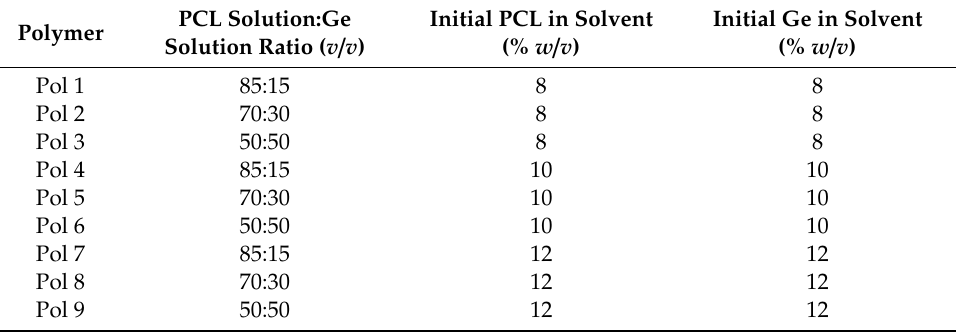
Table 2. Polymer solutions to be prepared from polycaprolactone (PCL) and gelatine (Ge) in trifluoroethanol